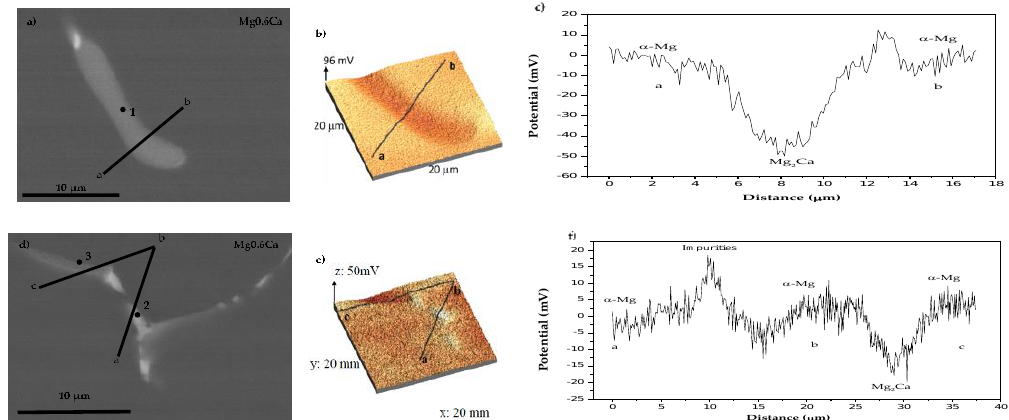
Figure 4. SEM backscattered images ( a , d ), surface potential maps ( b , e ) and potential profile ( c , f ) in